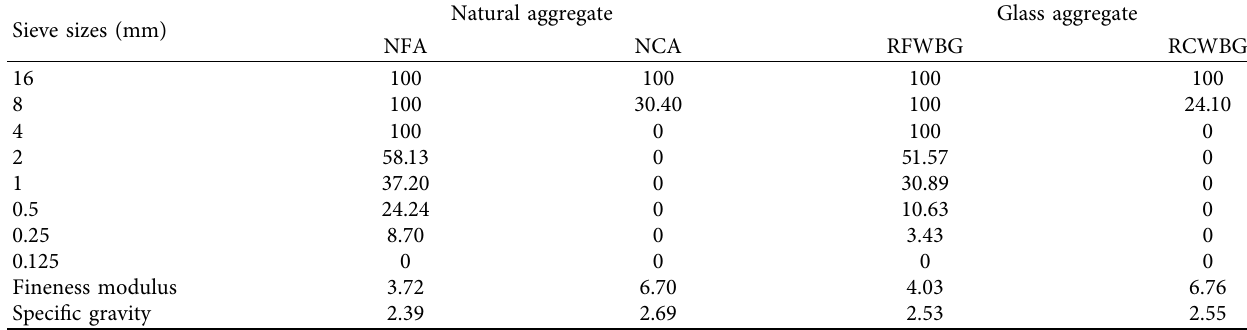
Table 2: Physical characteristics of natural and glass aggregates [19].